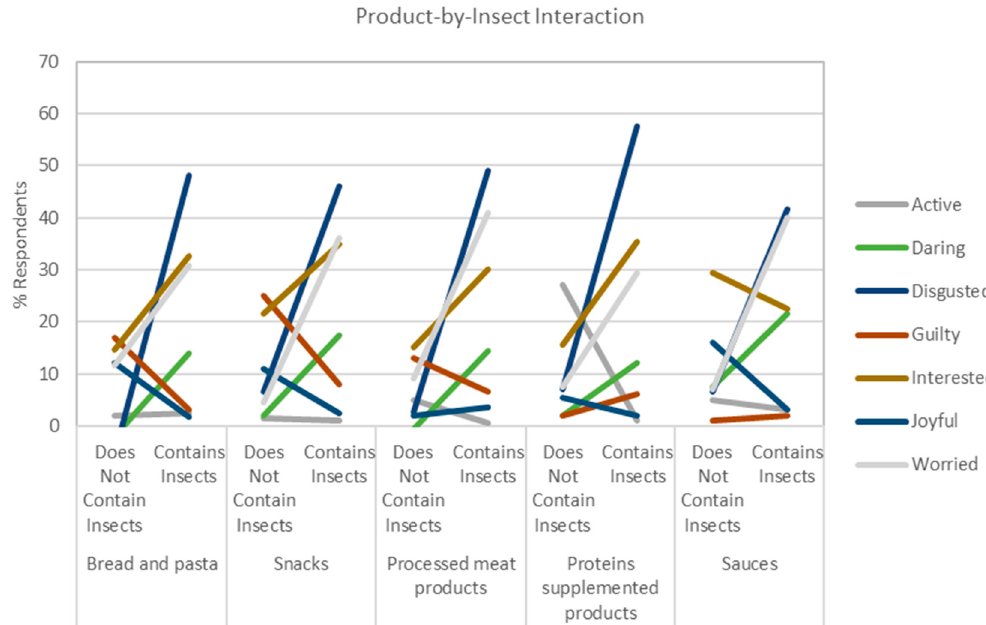
Figure 5. Effect of the interaction of the Insect Presence Information and the Product Category on the feelings bored, calm, happy, nostalgic, secure, and warm. The y-axis indicates the percentage of respondents checking the emotions, values that have been plotted using the regression model built from the ANOVA results, and the x-axis is the Insect Presence Information by each Product Category.